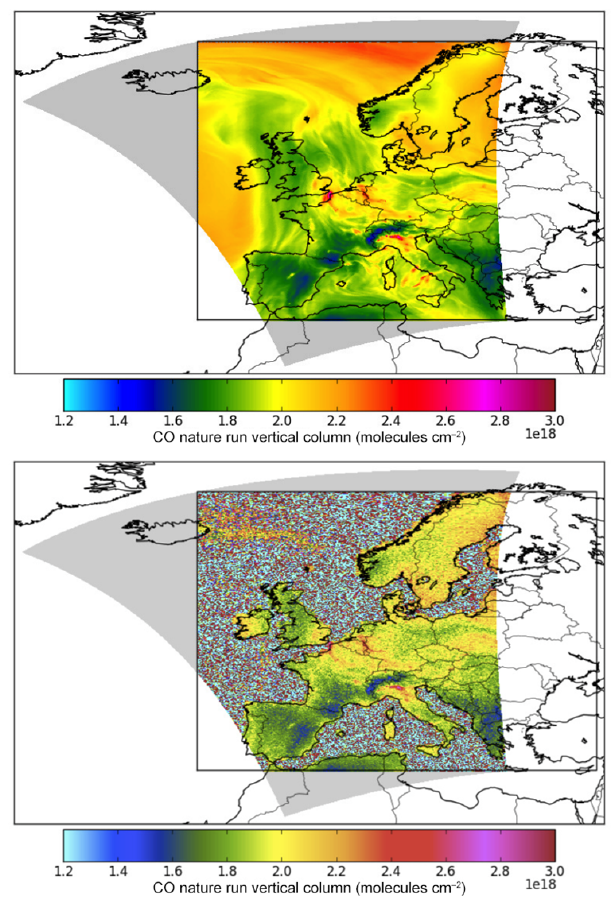
Figure 5. Top: nature run co-located to the synthetic S-5P obser- vations for the 12:34 orbit on 1 June 2003. Bottom: corresponding synthetic